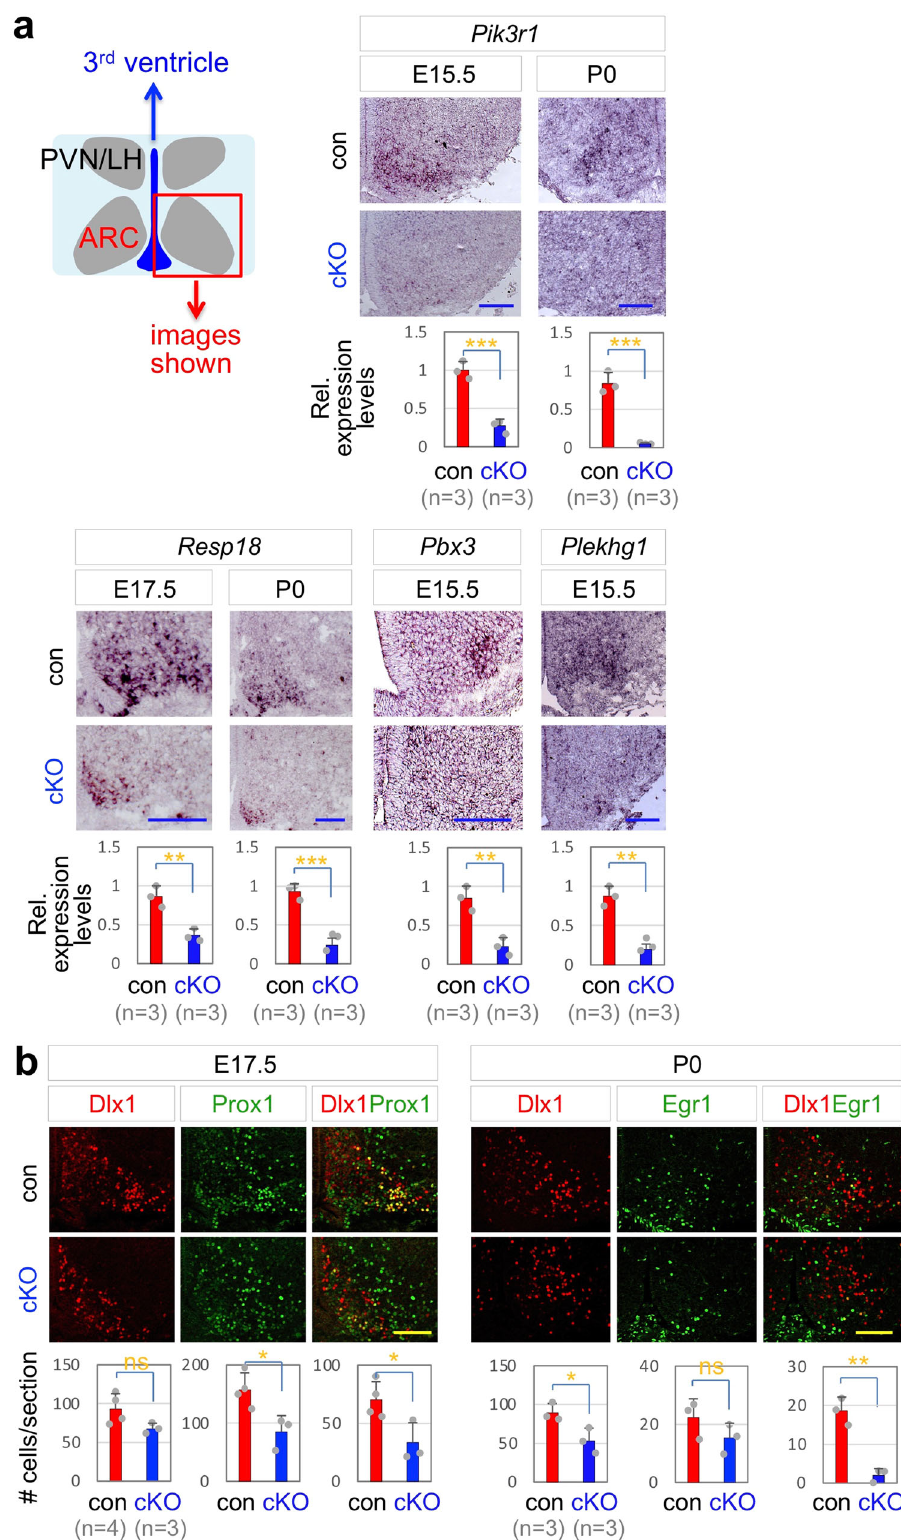
Fig. 6 Mll4 -cKO show reduced expression of Mll4-target genes in developing GHRH-neurons. a ISH analyses of expression of Mll4-target genes in Mll4 - cKO and their littermate controls at indicated stages. b IHC analyses of coexpression of transcription factors whose genes are targeted by Mll4; the number of Dlx1 only, Prox1 only, and Dlx1/Prox1 double-positive cells at E17.5, and the number of Dlx1 only, Egr1 only, and Dlx1/Egr1 double-positive cells at P0 in Mll4 -cKO and controls. The number of mice used is as indicated below each genotype in parenthesis ( a , b ). The location of ISH/IHC images is schematically shown ( a ), which applies to all images in ( a , b ). Statistical differences were determined by two-sided Student ’ s t -test; * p < 0.05, ** p < 0.01, and *** p < 0.001. Column bars represent mean, error bars indicate the SD. Scale bars, 100 µ